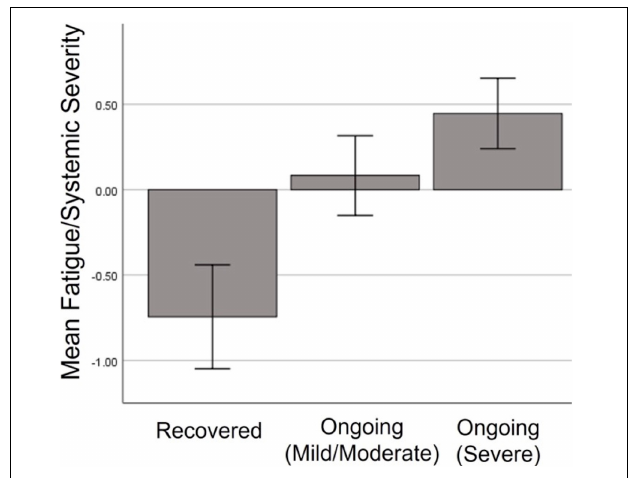
FIGURE 6 | Severity of Fatigue/Mixed symptom factor during initial illness among those who went on to full recover, or have ongoing mild or severe